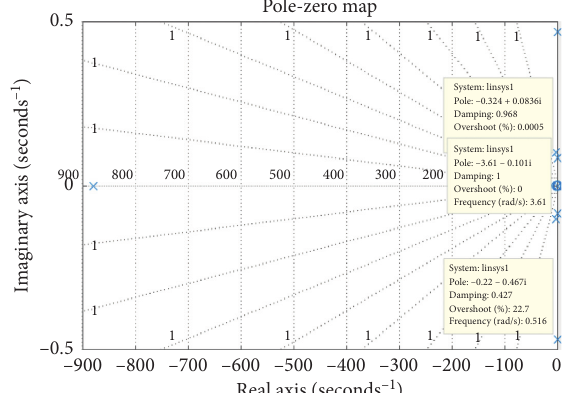
Figure 6: Closed loop pole distribution with the controller in Section 3.3.